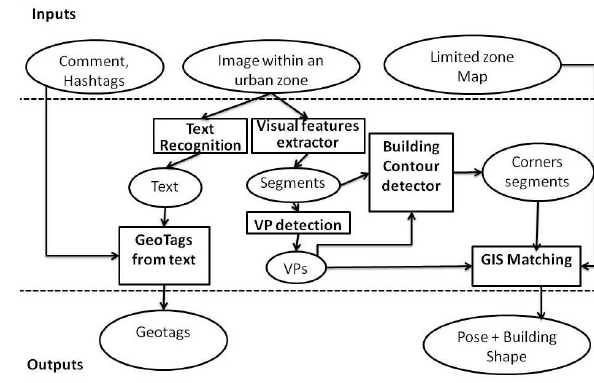
Figure 2. Data retrieval and preprocessing.